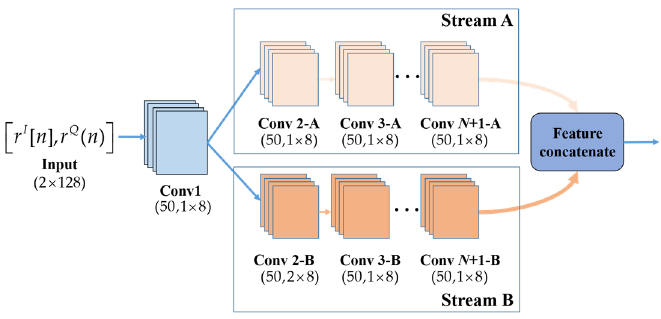
Figure 1. Illustration of the proposed MD-CNN module.